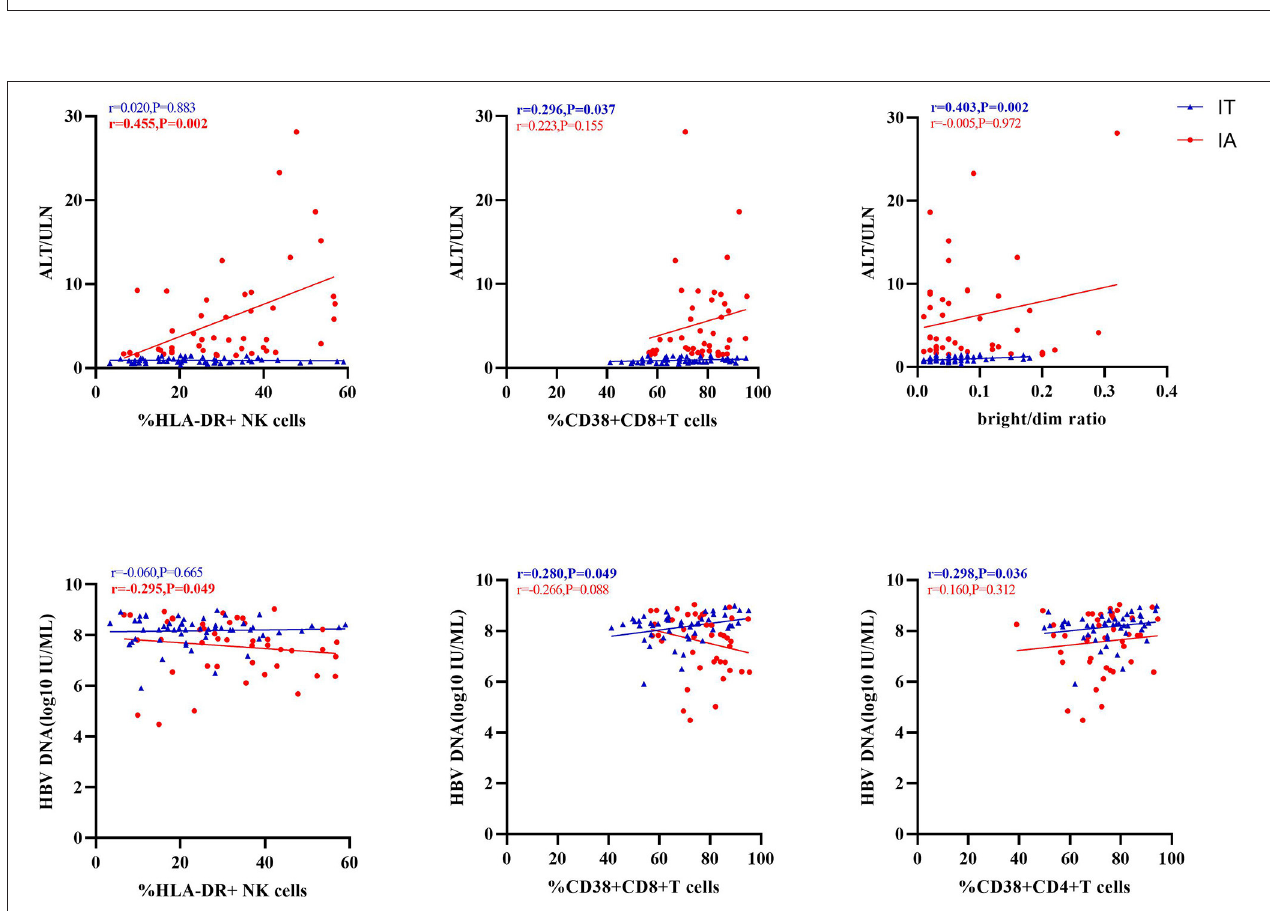
FIGURE 5 | Correlation of activation markers with alanine transaminase (ALT) or hepatitis B virus (HBV) DNA levels.